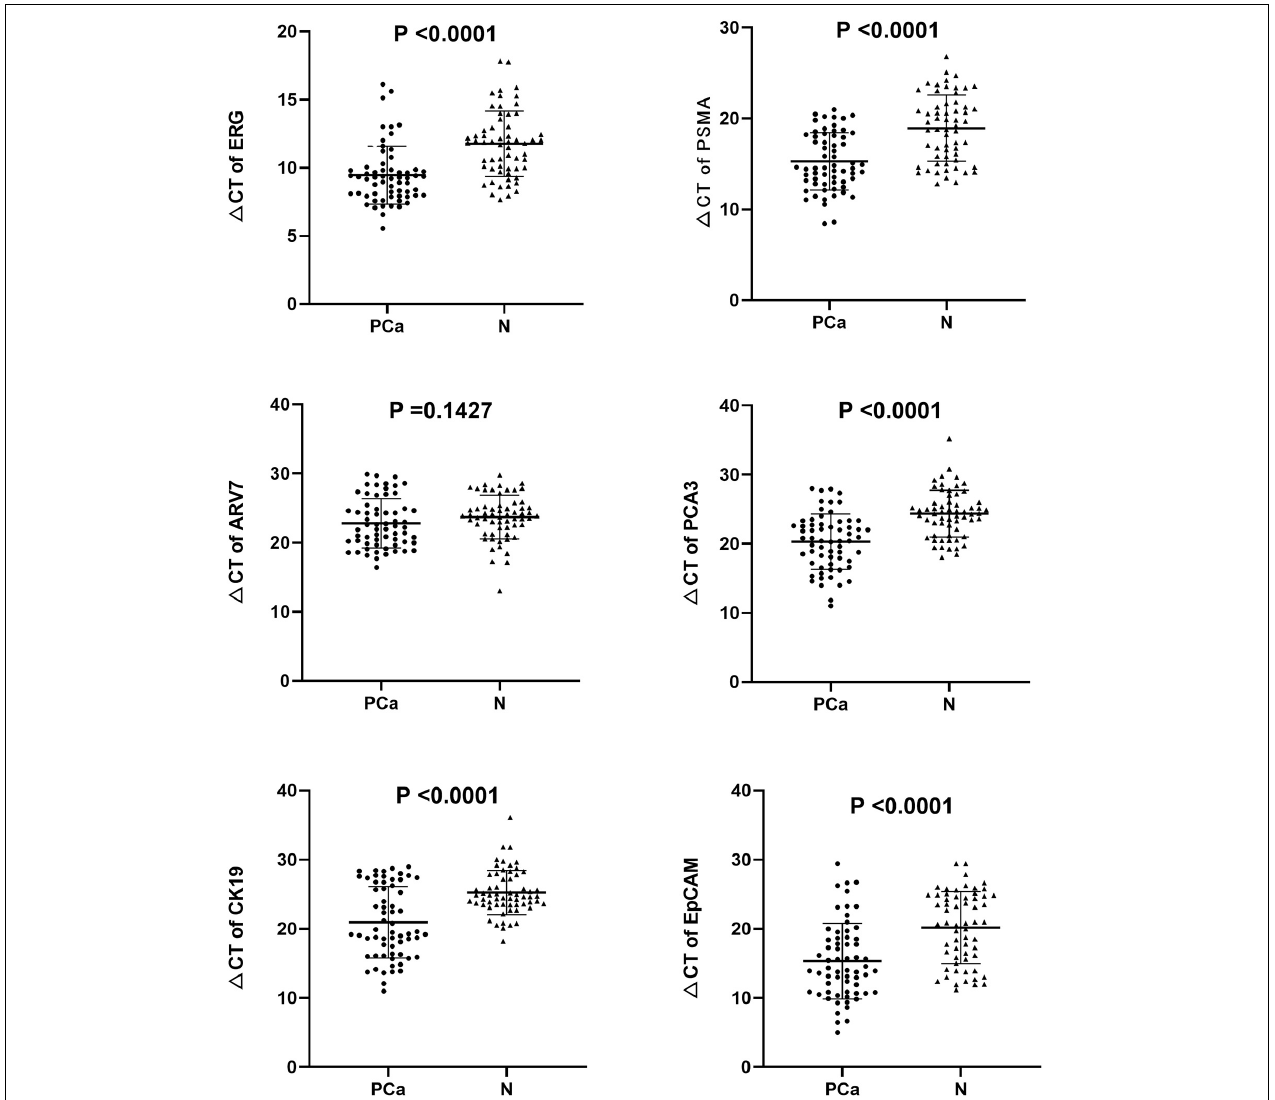
FIGURE 1 | Expression levels of the six mRNAs in PCa patients ( n = 63) and healthy subjects groups ( n = 61) by qRT-PCR in urinary exosomes. Statistical test: Student’s t -test. P < 0.05 was considered statistically significant (Difference between two